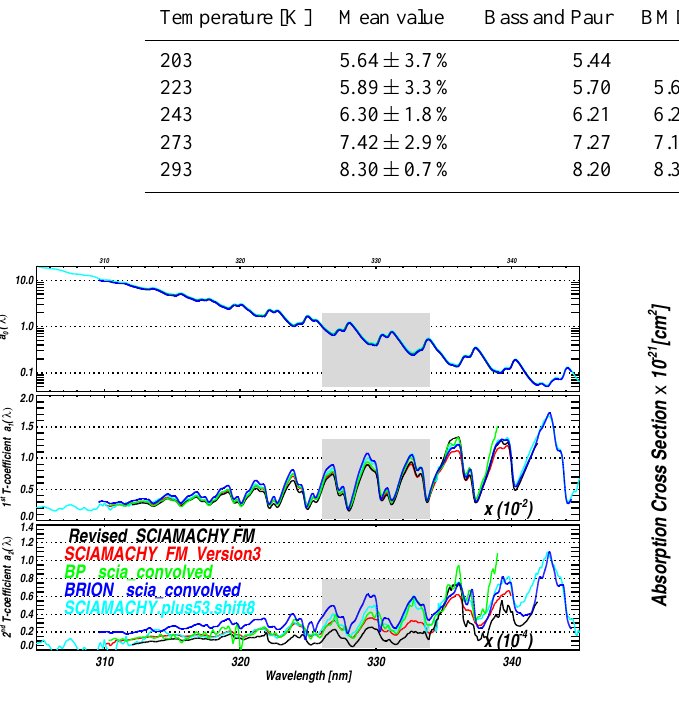
Fig. 8. Quadratic temperature coefficients ( a 0 (λ) , a 1 (λ) and a 2 (λ) in Eq. 2) for different ozone absorption spectra: SCIAMACHY re- vised and literature data convolved to SCIAMACHY slit function. The grey shaded area is the DOAS retrieval window. The cross sec- tion labelled “SCIAMACHY.plus53.shift8” is the Bogumil spectra scaled by +5.3% and shifted by 0.008nm as used in the current SCIAMACHY retrieval (Weber et al., 2011).